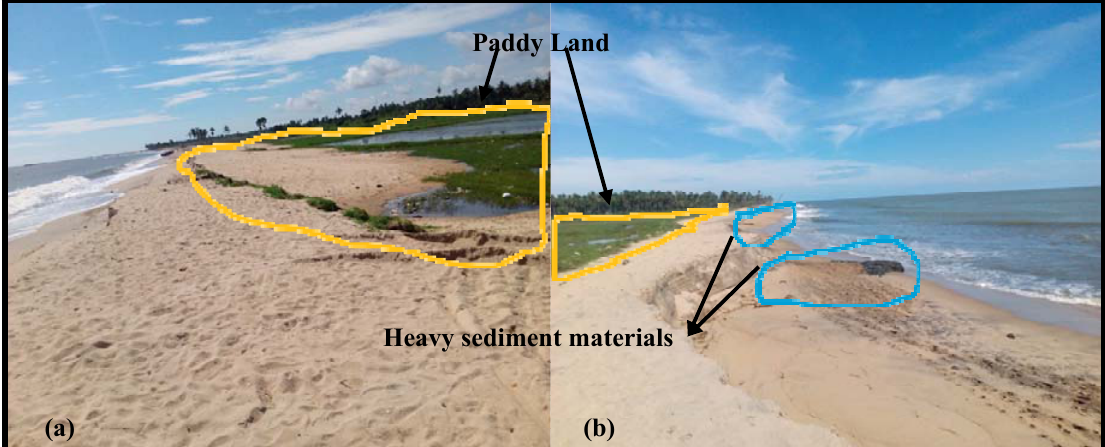
Figure 4. Profile of shoreline change vs. shoreline change envelope northwards of the harbor.